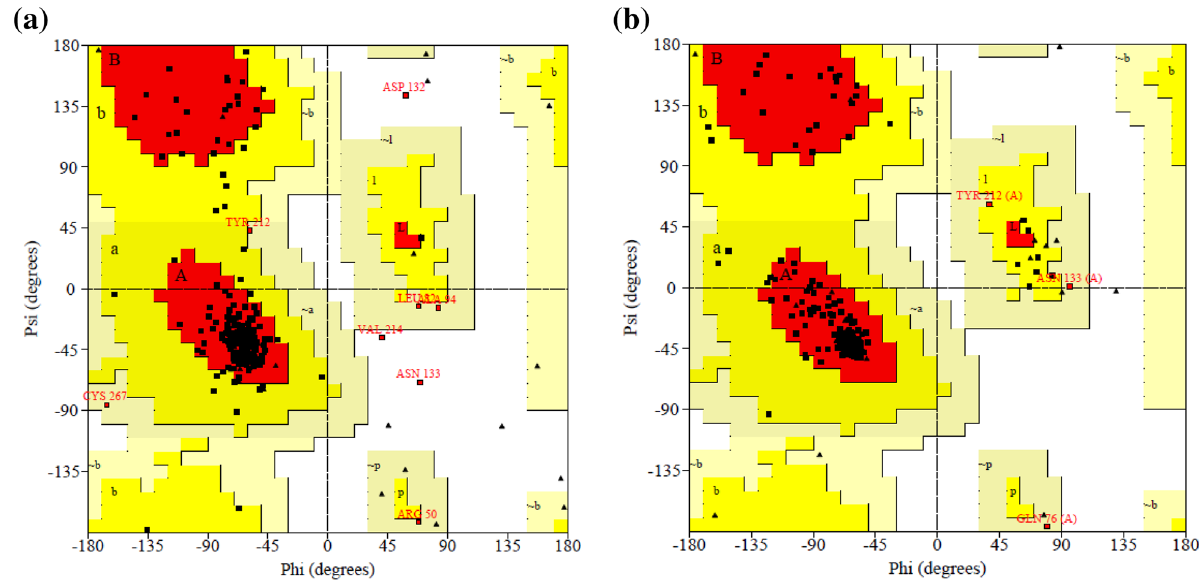
Figure 7. Ramachandran plots of a polypeptide backbone torsion angles psi (w) versus phi (u) of amino acids in the SWISS-MODEL-generated AQP-3 protein homology model generated ( a ) before and ( b ) after energy minimization.